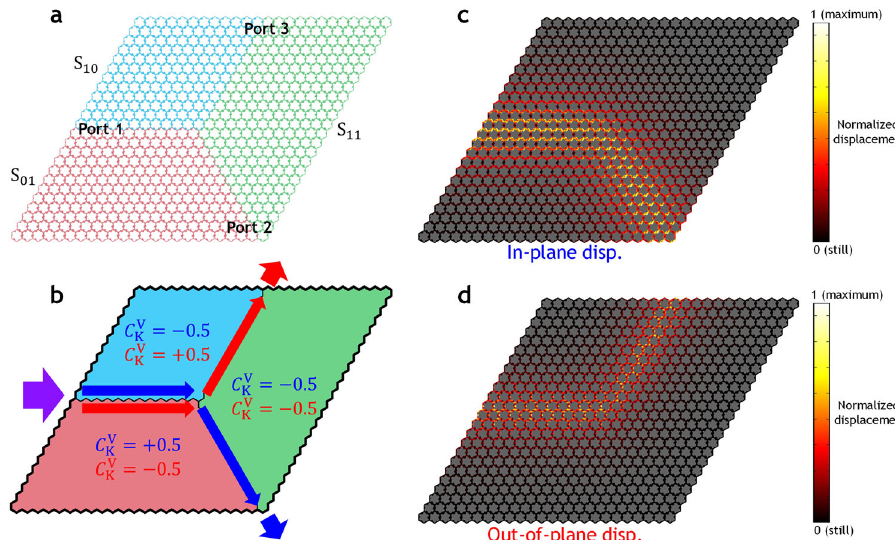
Fig. 6 Topologically protected elastic wave separation into in-plane polarized (IPP) and out-of-plane polarized (OPP) wave. a Con fi guration of phononic crystals (PCs) with Y-junction made of S 10 , S 01 , and S 11 for the separation of elastic waves. All edges between two PCs are zigzag edges, in which intervalley scattering is negligible. b Separation mechanism of an elastic wave at the Y-junction. The Violet arrow represents the hybridized vibration or wave injected to port 1. IPP and OPP wave trajectory are denoted as arrows, blue-colored for IPP and red-colored for OPP wave respectively, where ideal valley Chern numbers at valley K of each PCs are present to support the existence of the corresponding edge states. c , d In-plane displacement fi eld ( c ) and